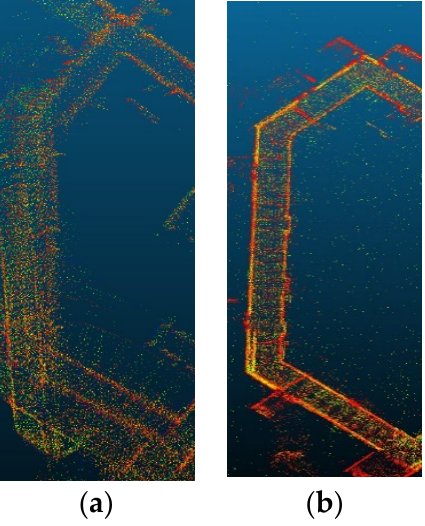
Figure 8. Comparison of mapping details at the corner of the corridor, where ( a ) the mapping of LeGO-LOAM has a significant deviation and ( b ) the mapping of the HSDLIO structure is clearer and more complete than LeGO-LOAM.